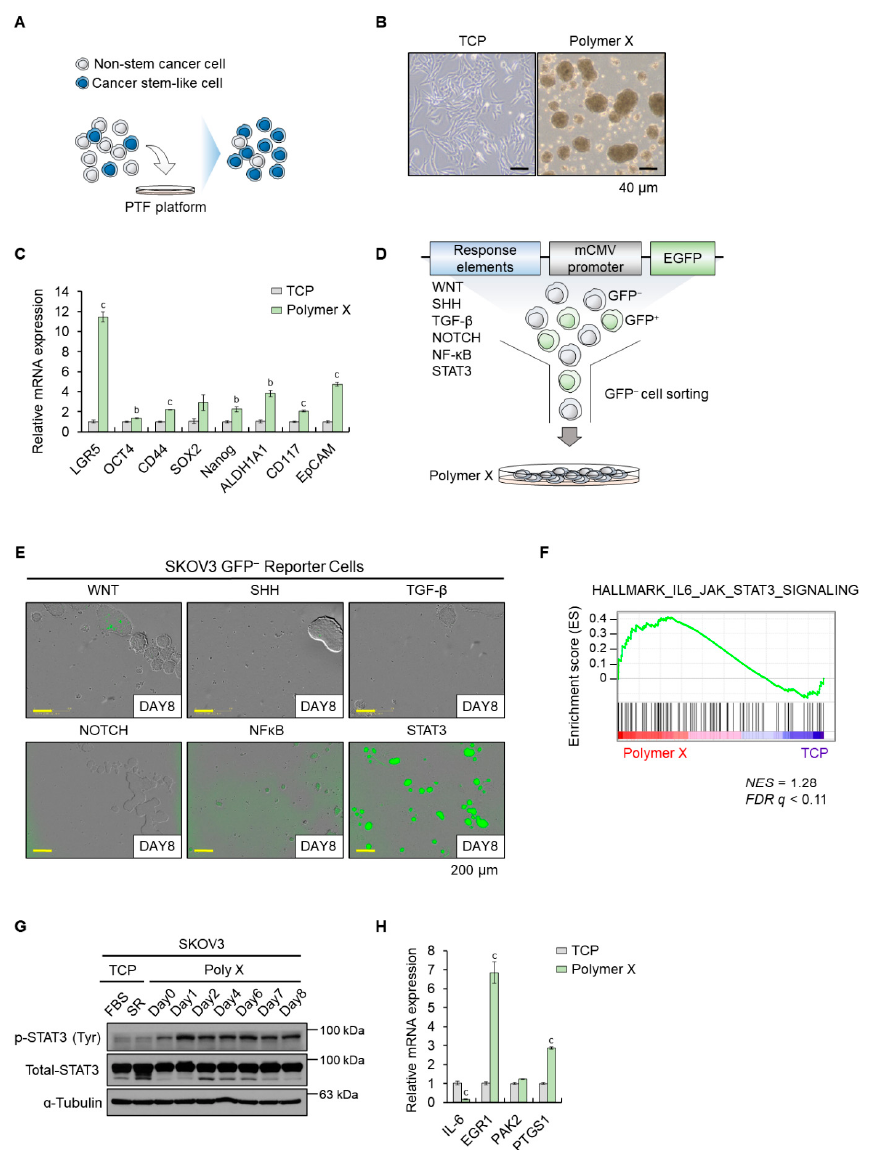
Figure 1. Acquisition of sphere formation ability and stemness signaling in the SKOV3 cells grown under polymer X culture condition. ( A ) Schematic illustration indicating the formation of tumor spheroid on polymer X. ( B ) Morphologies of SKOV3 cancer cells when cultured on TCP or polymer X for 8 days (d). Scale bar, 40 µm. ( C ) The mRNA levels of each indicated gene compared between cells cultured on TCP versus polymer X, as determined by real-time PCR. Data are expressed as mean ± SEM. Two-tailed Student’s t -test was used to analyze the statistical significance between each group ( n = 3 for each group). b: p < 0.01; c: p < 0.001. ( D ) A schematic diagram showing GFP-negative population in cells cultured on polymer X and sorted by establishing a reporter system. ( E ) Image obtained by culturing each GFP-negative cell line transduced with each reporter system vector as indicated on polymer X for 8 days using IncuCyte system. Scale bar, 200 µ m. ( F ) Gene set enrichment analysis (GSEA) displayed JAK-STAT3 signaling signature enrichment in SKOV3 cancer cells cultured on polymer X. ( G ) Cell lysates from SKOV3 cancer cells cultured on TCP or polymer X by date were immunoblotted with antibodies specific to pY705-STAT3 (p-STAT3), total STAT3, and α -tubulin. ( H ) The mRNA levels of the STAT3 target genes compared between cells cultured on TCP versus polymer X, as determined by real-time PCR. Data are expressed as mean ± SEM. Two-tailed Student’s t -test was used to analyze the statistical significance between each group ( n = 3 for each group). c: p <